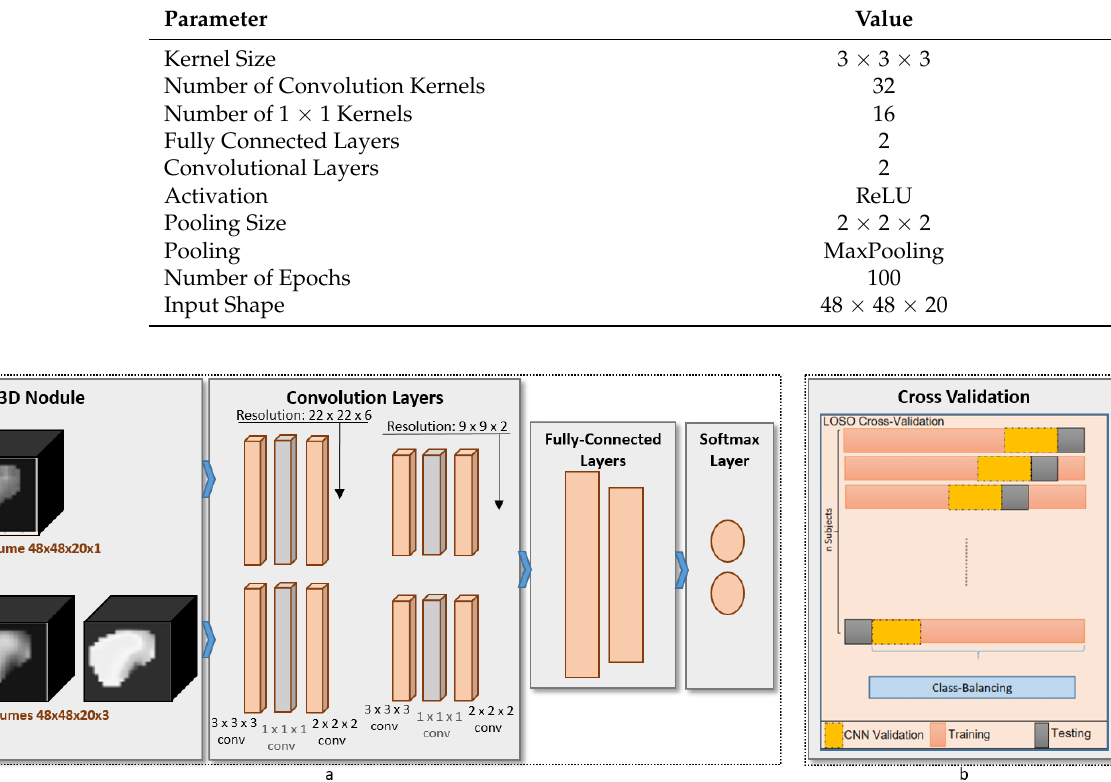
Figure 3. ( a ) Schematic diagram of the proposed CAD system that shows the design and the layers of the multi-input 3D CNN deep-learning framework. ( b ) Illustrative diagram that shows the cross-validation criteria used in our